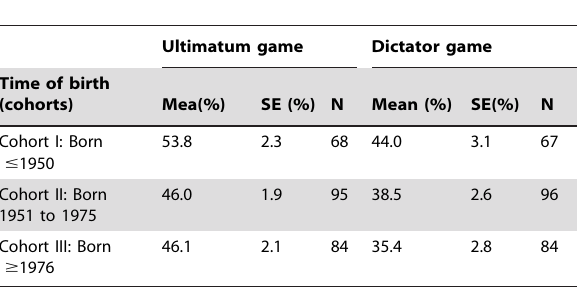
Table 2. Participants’ offers (in % of 100 yuan) in the ultimatum game and the dictator game by cohorts.